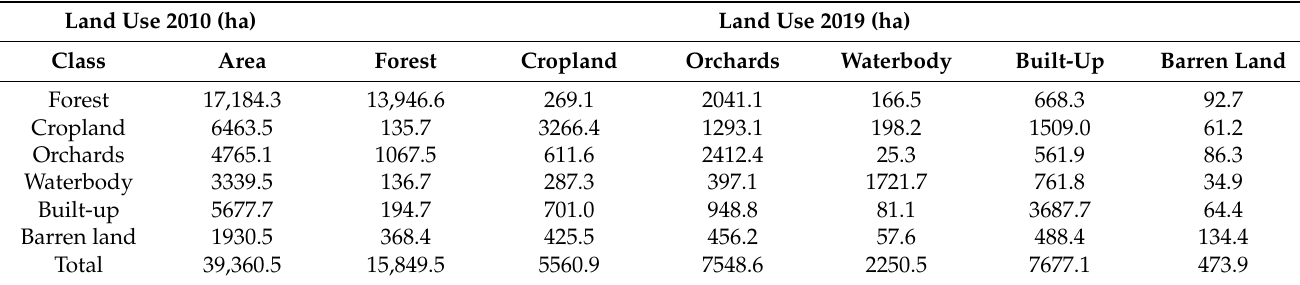
Table 7. The transformation matrices for changes of LULC classes from 2010 to 2019.